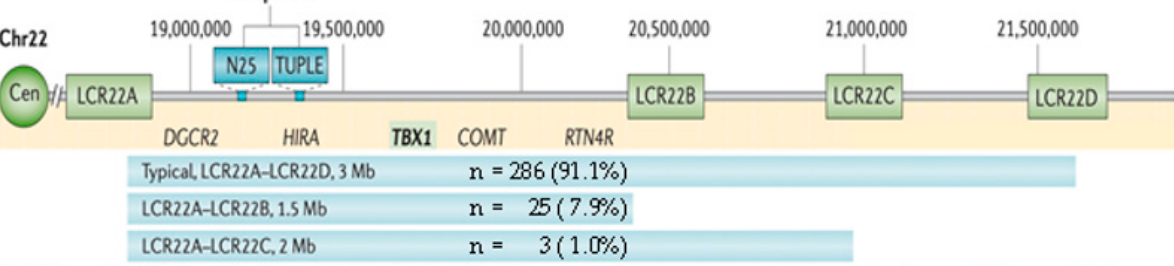
Figure 1. The common types of 22q11.2 deletion extent within the LCR22A-LCR22D region and the frequencies of each for the n = 314 adults used in regression analyses .